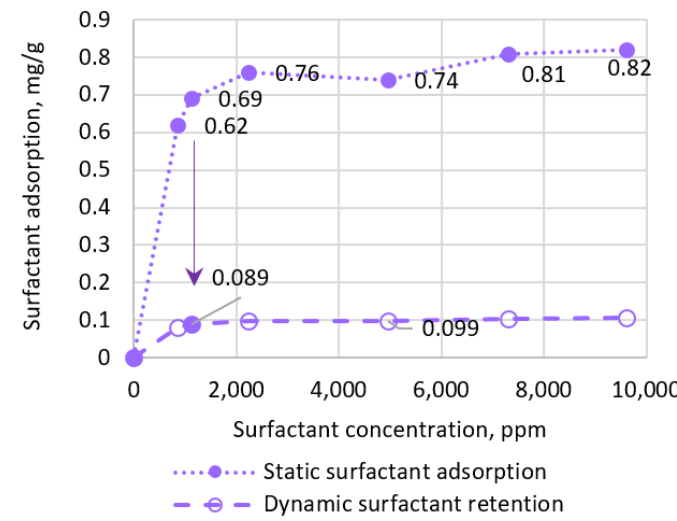
Figure 7. Curve of adsorption dependence on polymer concentration.